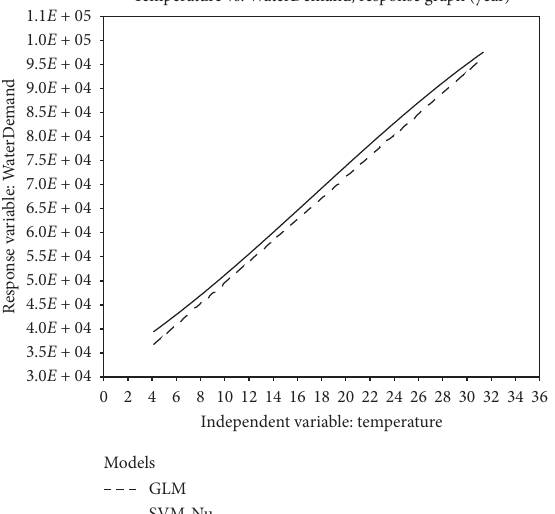
Figure 9: The reaction of water consumption to air temperature with annual conditions using GLM and SVM-Nu models.